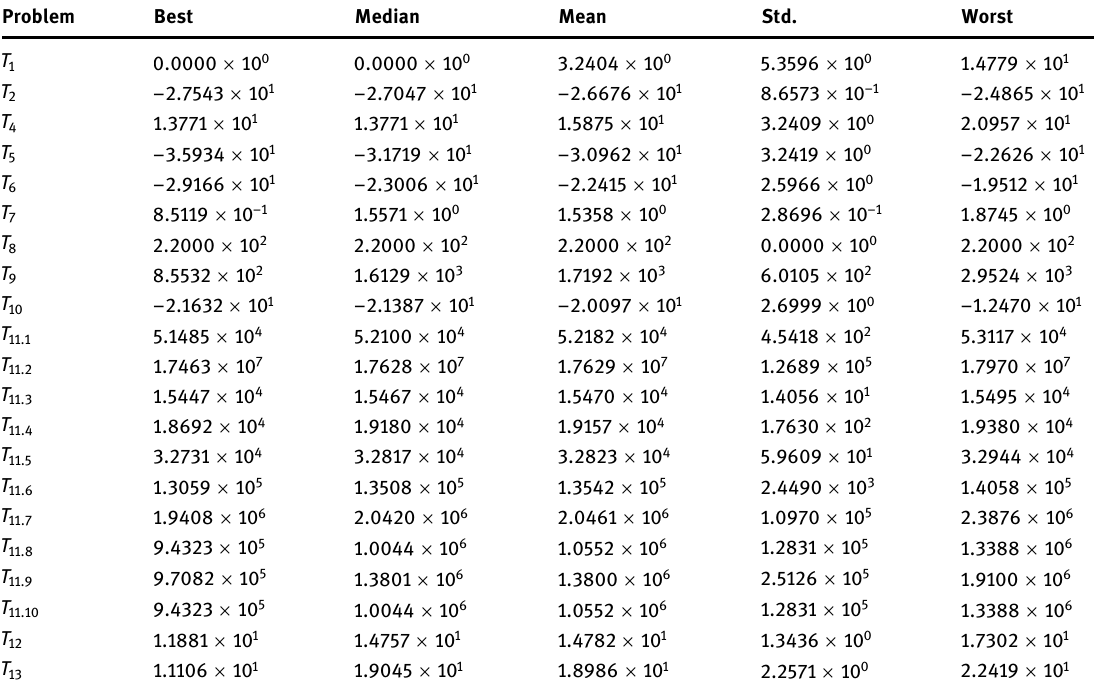
Table 4: The CEC 2011 function values achieved by Jaya2 over 25 runs and 150,000 function evaluations Problem Best Median Mean